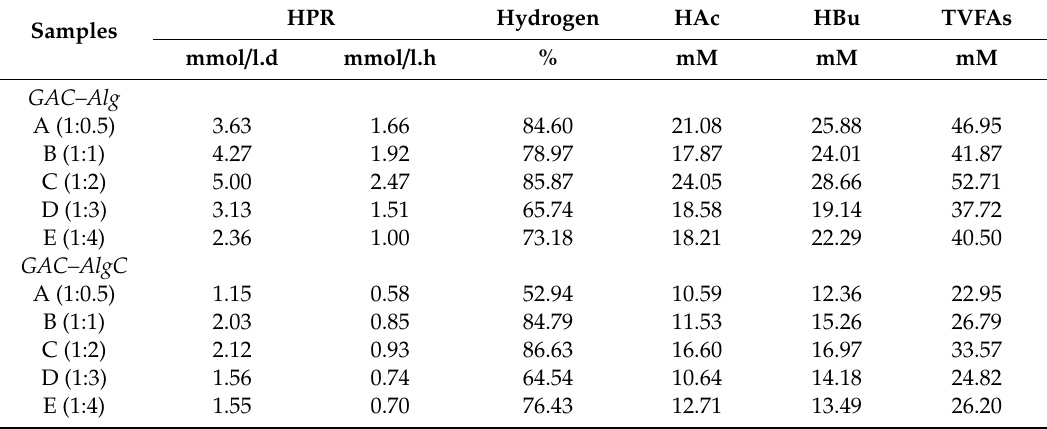
Table 6. Summary of total volatile fatty acids at various concentrations of GAC–Alg and GAC–AlgC, all at 200 mL working volume of a 250 mL modified bioreactor in batch